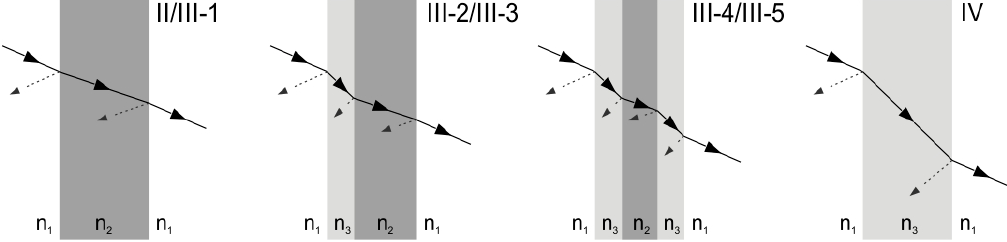
Figure 15. Scheme representation of light refraction during non-uniform melting of